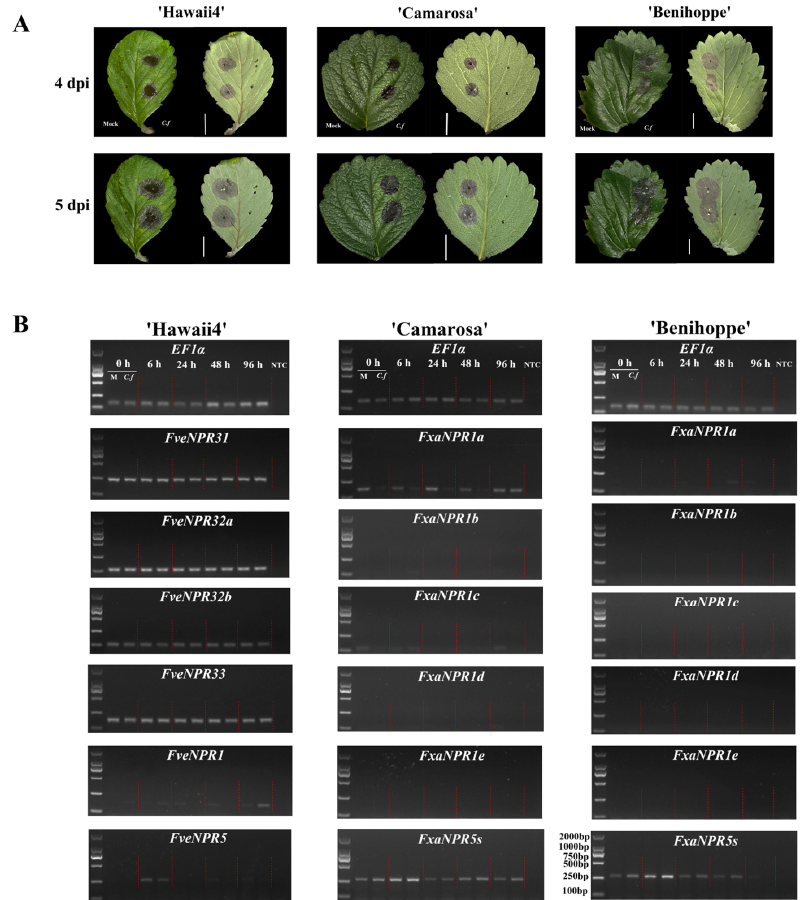
Figure 6. The expression responses of strawberry NPR -like genes upon Colletotrichum fructicola invasion in diploid “Hawaii4’ and octoploid cultivars ‘Camarosa’ and ‘Benihoppe’. ( A ) The typical symptoms induced by C. fructicola on wounded detached strawberry leaf blades at 25 °C were photographed at 4 and 5 dpi. The left and right side of each leaf blade (adaxial side up) was inoculated with two 10- µ L droplets of sterile water with 0.01% ( v / v ) Tween 20 (Mock, M) and conidia suspension (2 × 10 6 per mL, C. f ), respectively. Scale bar, 1 cm. ( B ) The semi-quantitative RT-PCR analysis of strawberry NPR -like genes. The third, fourth, and fifth compound leaves of sprayed inoculated plants ( C. f ) or mock-treated (M) were harvested at different hours post inoculation (hpi). The PCR cycle numbers are 40 and 28 for NPR1 -likes and the internal control EF1 α , respectively. In amplification for FveNPR31 , -32a , -32b , and -33 , 0.2- µ L original cDNAs was used as a template,